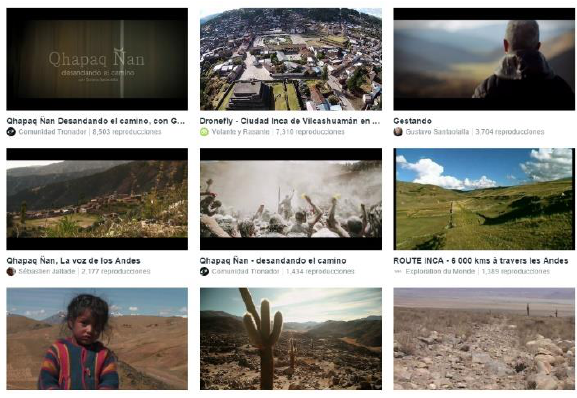
Figure 16.Search results: Qhapaq Ñan on the Vimeo Social Network. © Vimeo. Image: Screen capture,